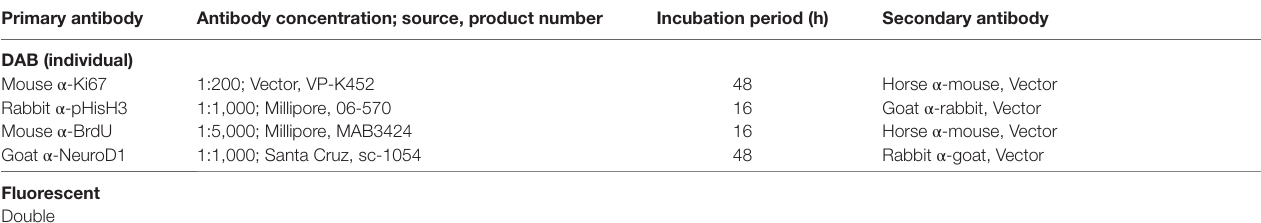
TaBle 1 | Antibodies. Primary